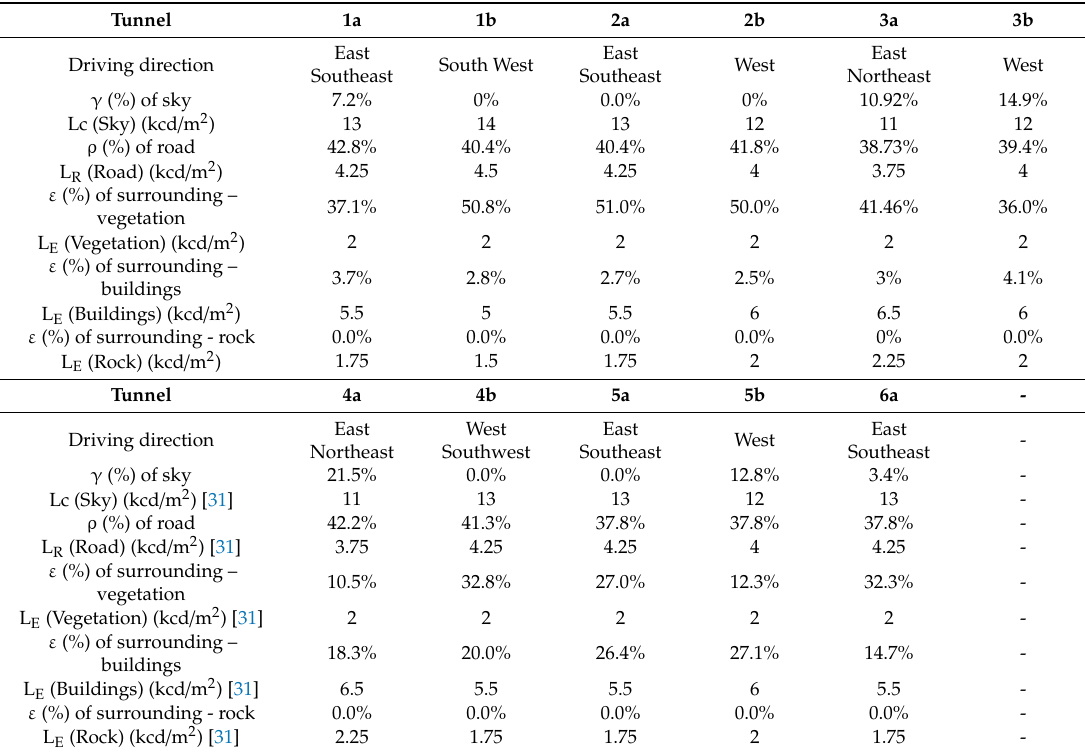
tra ffi c flow. The new calculated luminance values in each threshold zone are presented in Table 5. The corresponding Lth’ values varied from 26% to 60%, which was lower than the corresponding existing one Lth, a fact meaning that the lighting systems are over-dimensioned for all the tunnels. Table 4. Corresponding values used in Equation (1) in order to calculate the L20 [31] luminance for all examined tunnels.